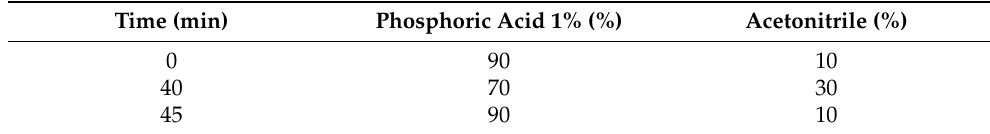
Table 1. HPLC-DAD analysis elution